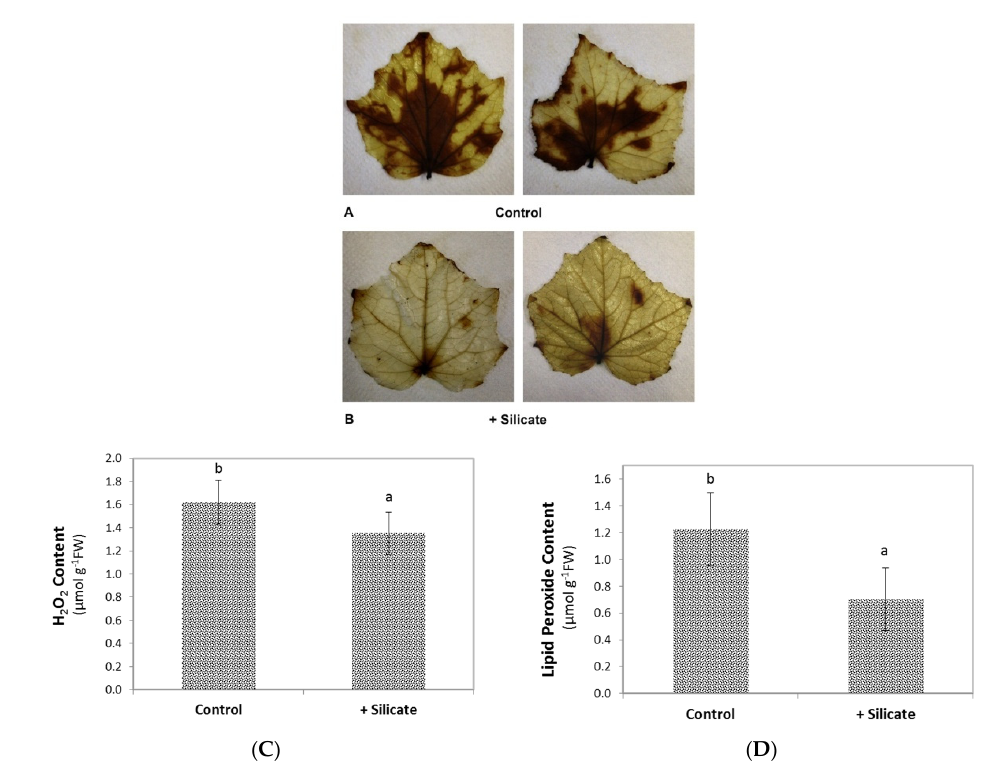
Figure 3. DAB staining of cucumber leaves of ( A ): control and ( B ): silicate-treated plants. ( C ): H 2 O 2 and ( D ): lipid peroxide content of control and Si-treated plants. Values are means ± SD and different letters above the bars indicate significant difference between the treatments (Tukey post hoc: p < 0.05); n = 8.